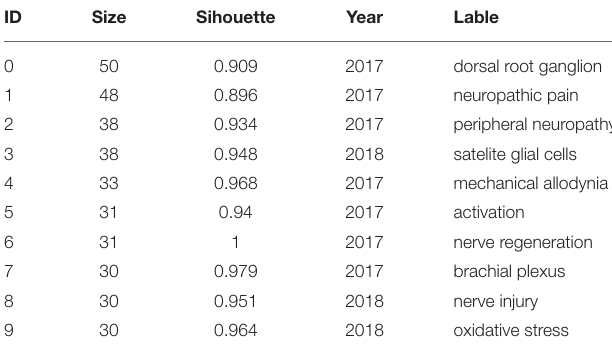
TABLE 3 | Cluster analysis of